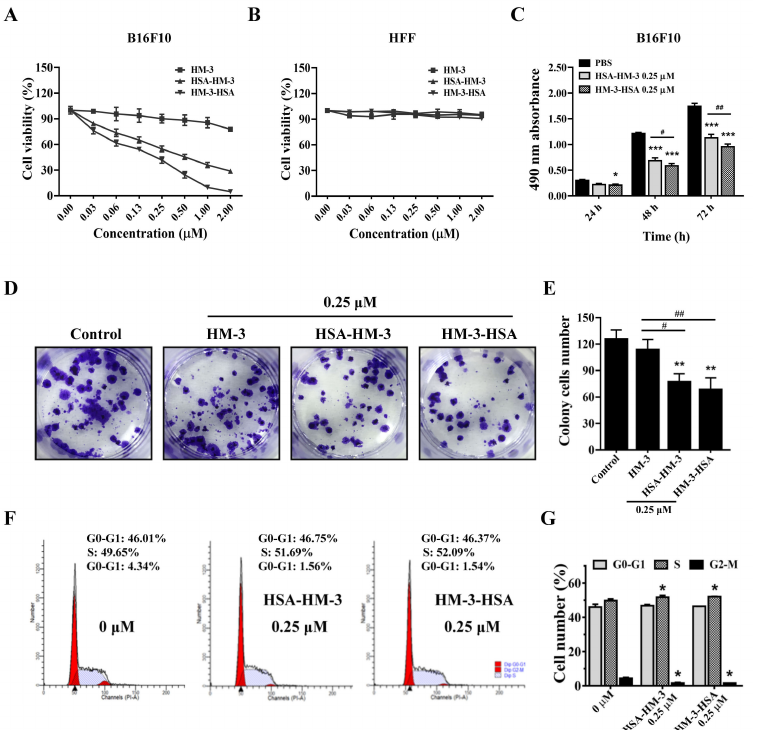
Figure 5. The effect of HM-3/HSA on B16F10 cells’ viability. ( A , B ) HM-3/HSA inhibited B16F10 and HFF cells’ viability in a dose-dependent manner. Cells were incubated with various doses of HSA-HM-3 or HM-3-HSA for 48 h, followed by cell viability evaluation using the MTT assay. ( C ) HM-3/HSA inhibited B16F10 cells’ viability within 72 h. Cells were incubated with HSA-HM-3 (0.25 µ M) and HM-3-HSA (0.25 µ M) for 24, 48, and 72 h, followed by cell viability evaluation using the MTT assay. ( D , E ) HM-3/HSA inhibited B16F10 cells’ colony formation. Cell proliferation was measured by the colony formation assay in B16F10 cells treated with the indicated concentrations of HM-3/HSA for 7 days. ( F , G ) HM-3/HSA induced S-phase cell cycle arrest in B16F10 cells. The analysis of cell cycle arrest was done by the PI staining assay after 48 h of incubation with HM-3/HSA and cell-cycle distribution was determined by flow cytometry. Control: cells treated with the PBS vehicle only. Data shown are means ± standard deviation from three independent experiments. * p < 0.05, ** p < 0.01, and *** p < 0.001 vs. control; # p < 0.05 and ## p <